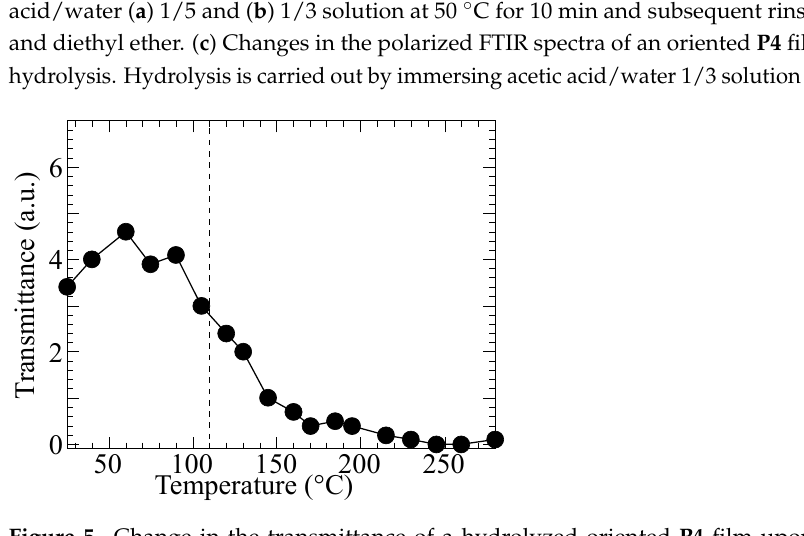
Figure 5. Change in the transmittance of a hydrolyzed oriented P4 film upon heating between crossed